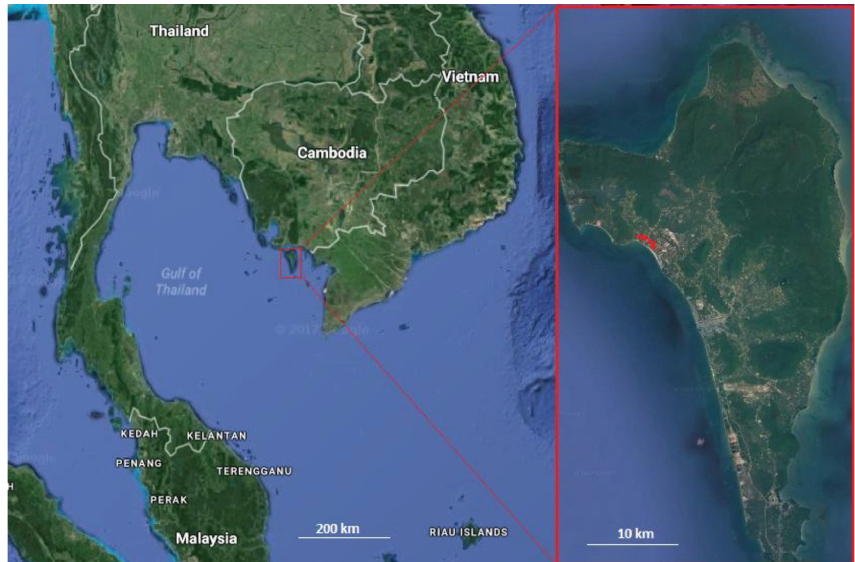
Figure 1: Study site location, Ph´u Qu ố c Island.